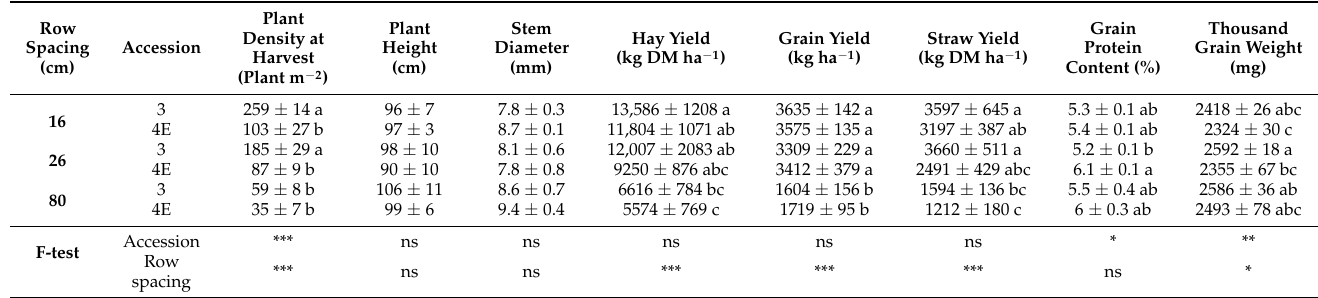
Table 4. Row spacing, plant density at harvest, yields, growth, and grain-quality parameters of quinoa accessions 3 and 4E sown in January 2019. Results are presented as mean value ± standard error.